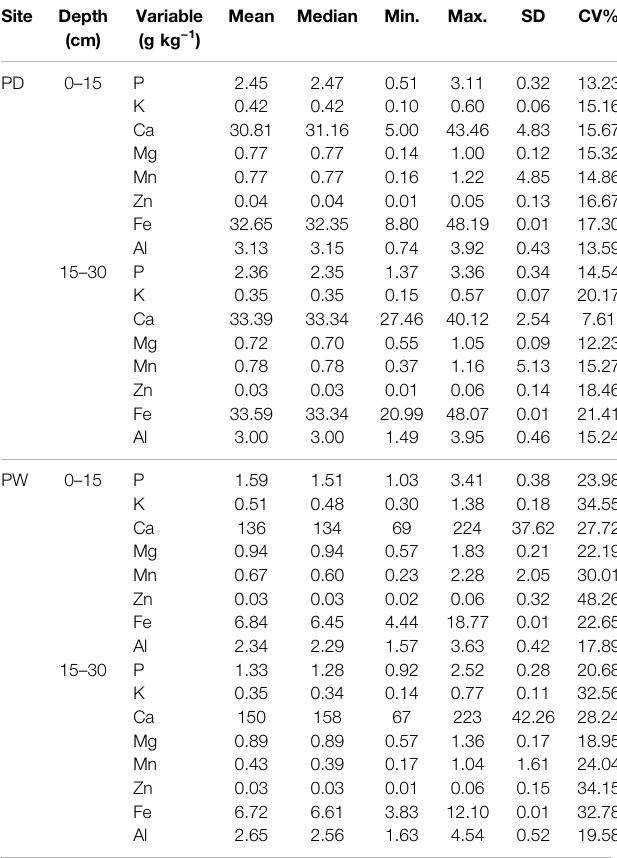
TABLE 2 | The concentrations of total elements of in the surface and subsurface horizons of the drained and rewetted peatlands. Site Depth Variable Mean (cm) (g kg − 1 )